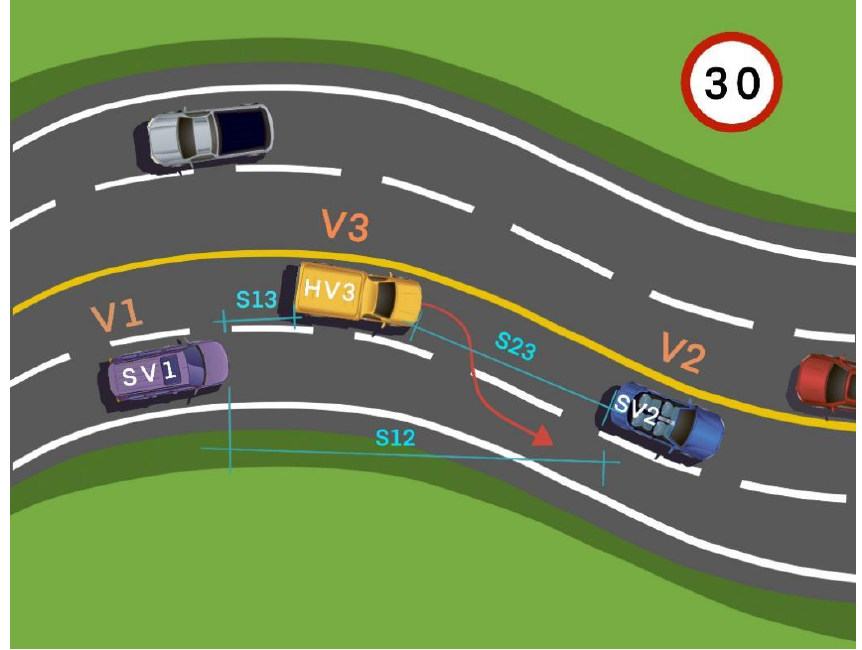
Figure 9. An example of the influence of vehicle lateral dynamics on lane change decisions and speed prediction.